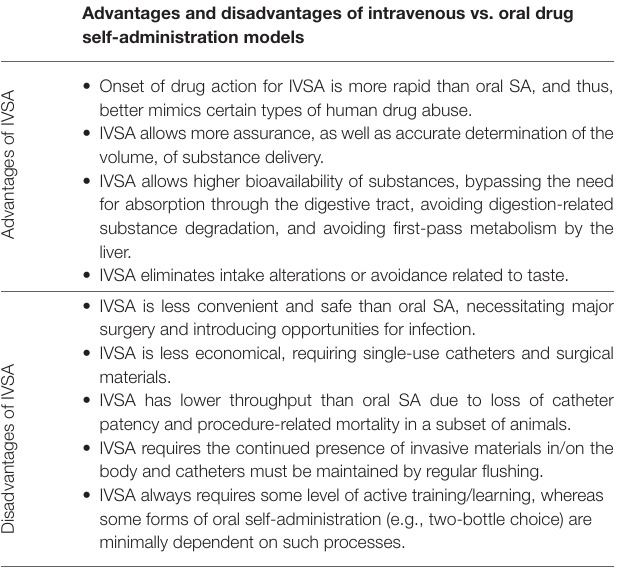
TABLE 2 | Considerations for mouse intravenous self-administration compared to other methods. Comparison of mice and rats for use in